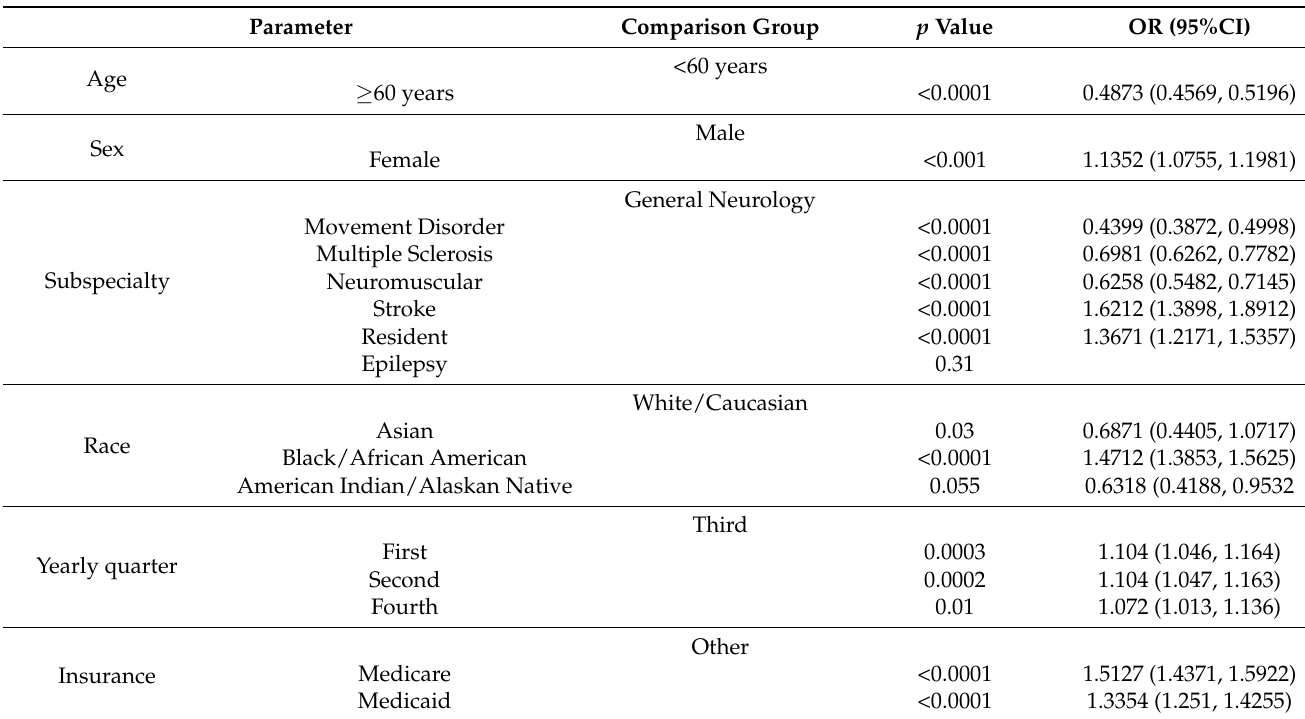
Table 2. Comparison between groups based on age, sex, subspecialty clinic, race, yearly quarter, and